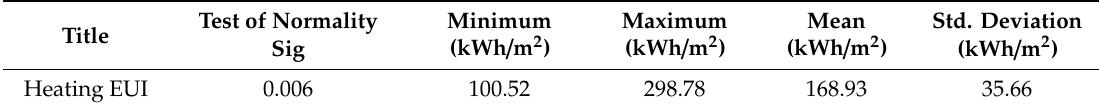
Table 1. Descriptive statistics of heating EUI.